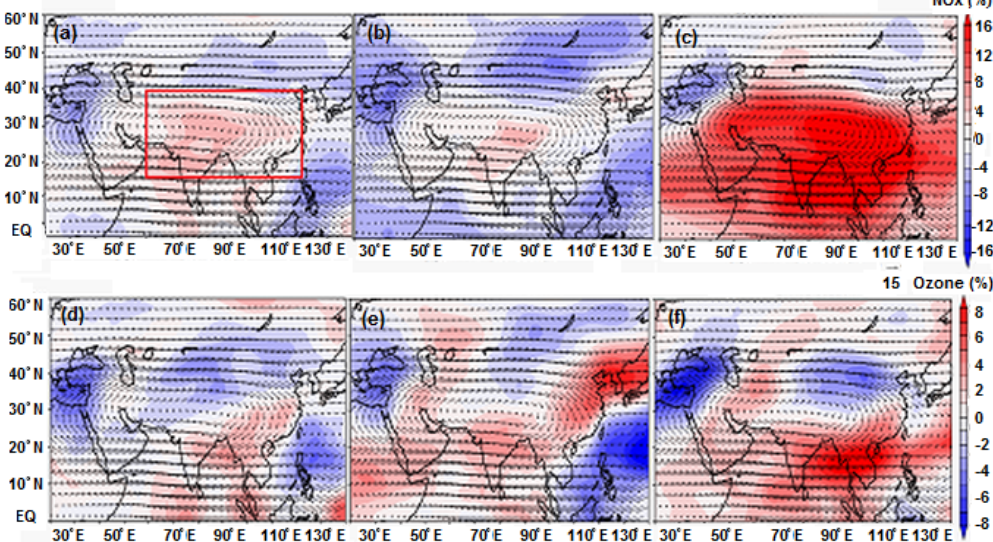
Figure 5. Latitude–longitude cross section of percentage NO x anomalies averaged for the monsoon season (June–September) at 110hPa obtained from (a) Ind38, (b) Ind73, and (c) Chin73 simulations. (d–f) show the same but for percentage ozone anomalies at 110hPa for the (d) Ind38, (e) Ind73, and (f) Chin73 simulations. Black arrows indicate horizontal winds at 110hPa. The red box in (a) indicates the ASM anticyclone region used to compute the associated radiative forcing regional average.